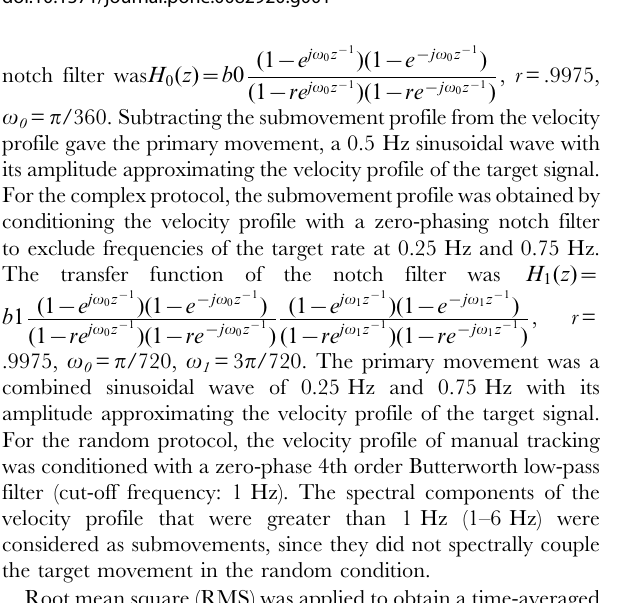
Figure 1. Experiment procedure, system setup, and data recording.